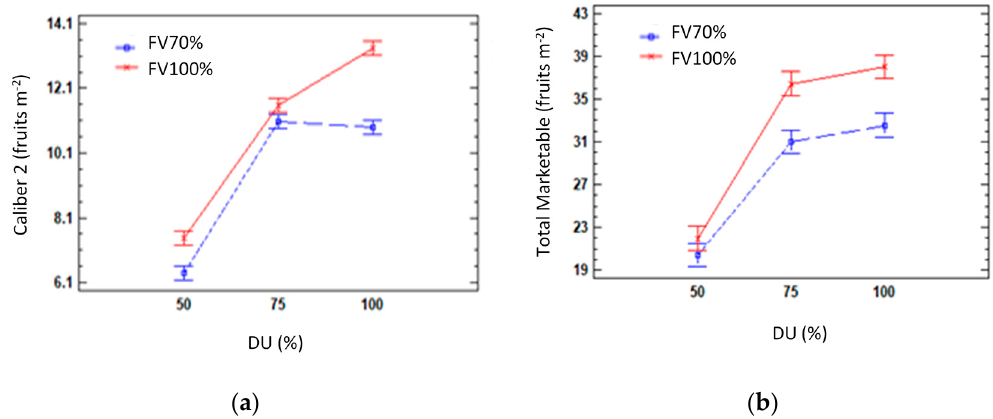
Figure 5. Interaction between DU and FV for number of fruits of Caliber 2 ( a ) and total marketable number of fruits ( b ). Averages and intervals LSD (least significance difference) 95%.